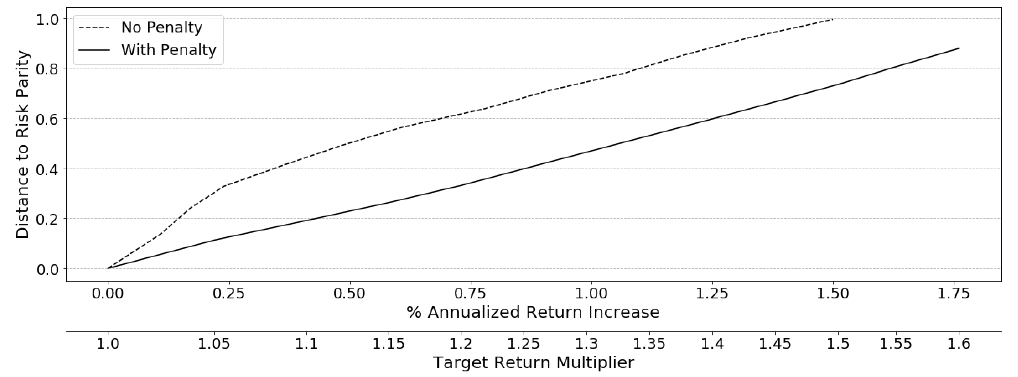
Figure 12. Risk parity property cost for enhanced returns